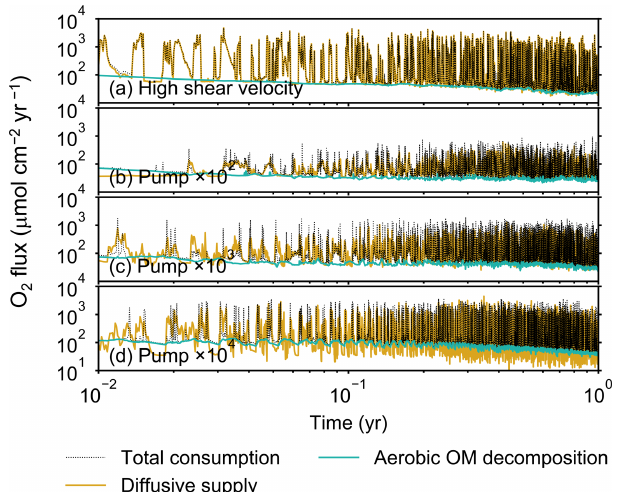
Figure E3. Time evolution of oxygen fluxes in simulations (a) with 10 × higher shear velocity but otherwise default settings and (b–d) increasing water flows at the time of ingestion/egestion by factors of (b) 10 2 , (c) 10 3 , and (d) 10 4 but with otherwise default settings. Only the absolute flux values of diffusive oxygen supply, aerobic decomposition of OM, and total oxygen consumption are shown.